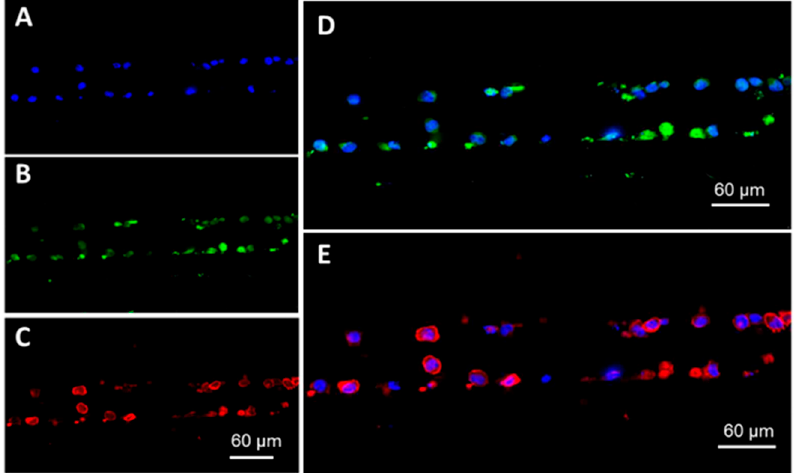
Figure 3. On-chip immunophenotyping of RPMI-8226 cells. ( A ) DAPI-labeled RPMI-8226 cell nucleus aligned at the entrance of the microtraps formed by the cross-channels and the cover plate assembled to the device. ( B ) CD138 expression of the RPMI-8226 cells and ( C ) CD38 expression for the same cells. ( D ) Composite image of CD138 expression (FITC channel) with the cell nucleus (DAPI channel of the microscope). ( E ) Composite image of CD38 expression (APC channel) with the cell nucleus that was DAPI stained. Exposure times were DAPI 50 ms, FITC 500 ms, and APC 1500 ms with 20 × magnification. All images were collected using the Keyence fluorescence microscope. Shown in this fluorescence image are cells aligned along one interleaving input channel with cross-channels on either side of that